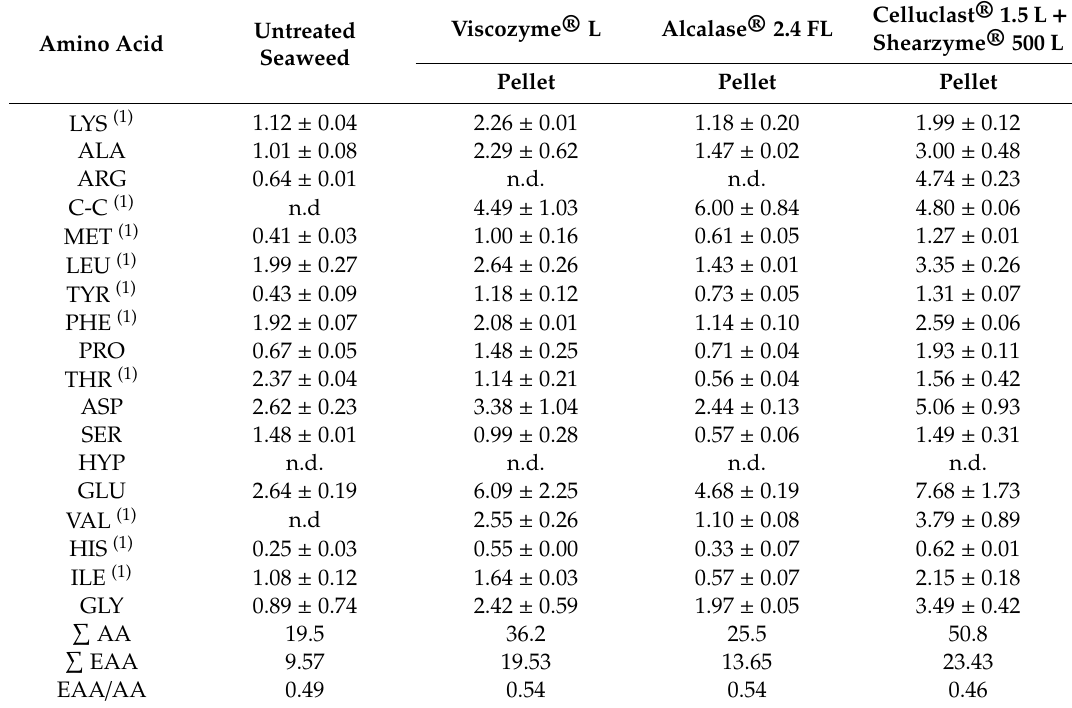
Table 5. Amino acid composition (mg amino acid / g DM), total essential amino acid content ( the essential amino acid ratio (EAA / AA) of the untreated samples of Eucheuma denticulatum seaweed, and extracted protein (pellet) obtained from the di ff erent selected enzymes used. The numbers are given as averages ± standard deviations of triplicates (n =